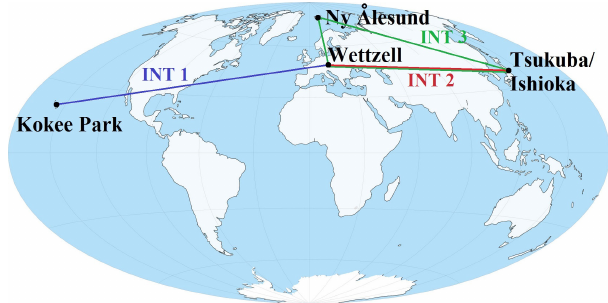
Figure 1. Three different network configurations of VLBI Intensive